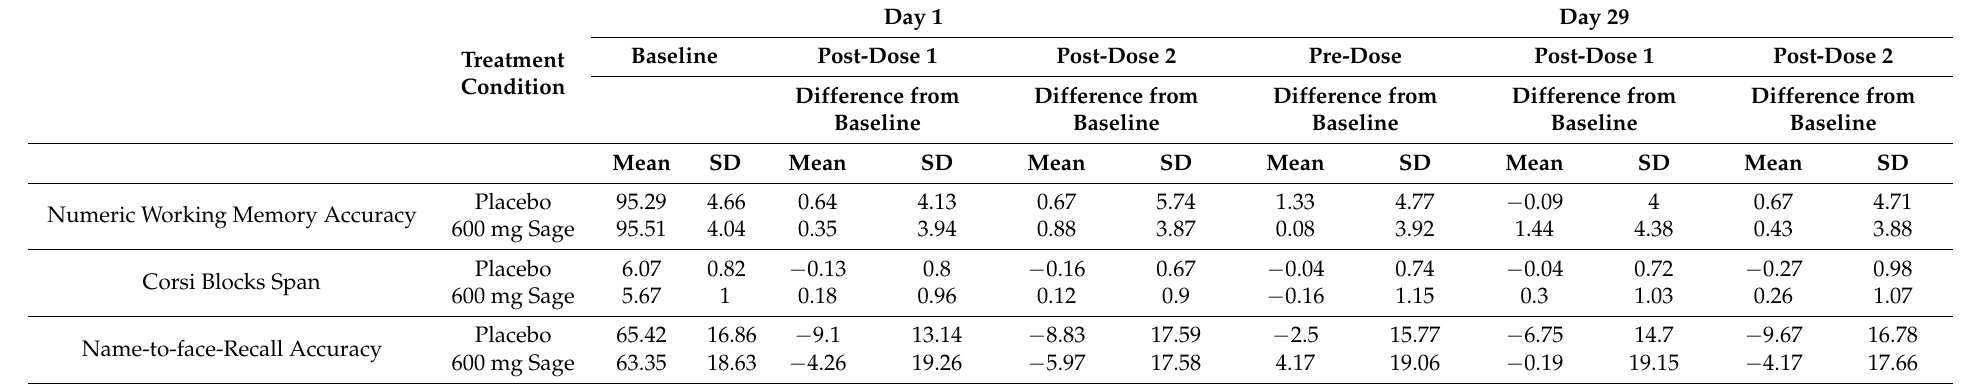
Table 2. Cognitive task scores in comparison with